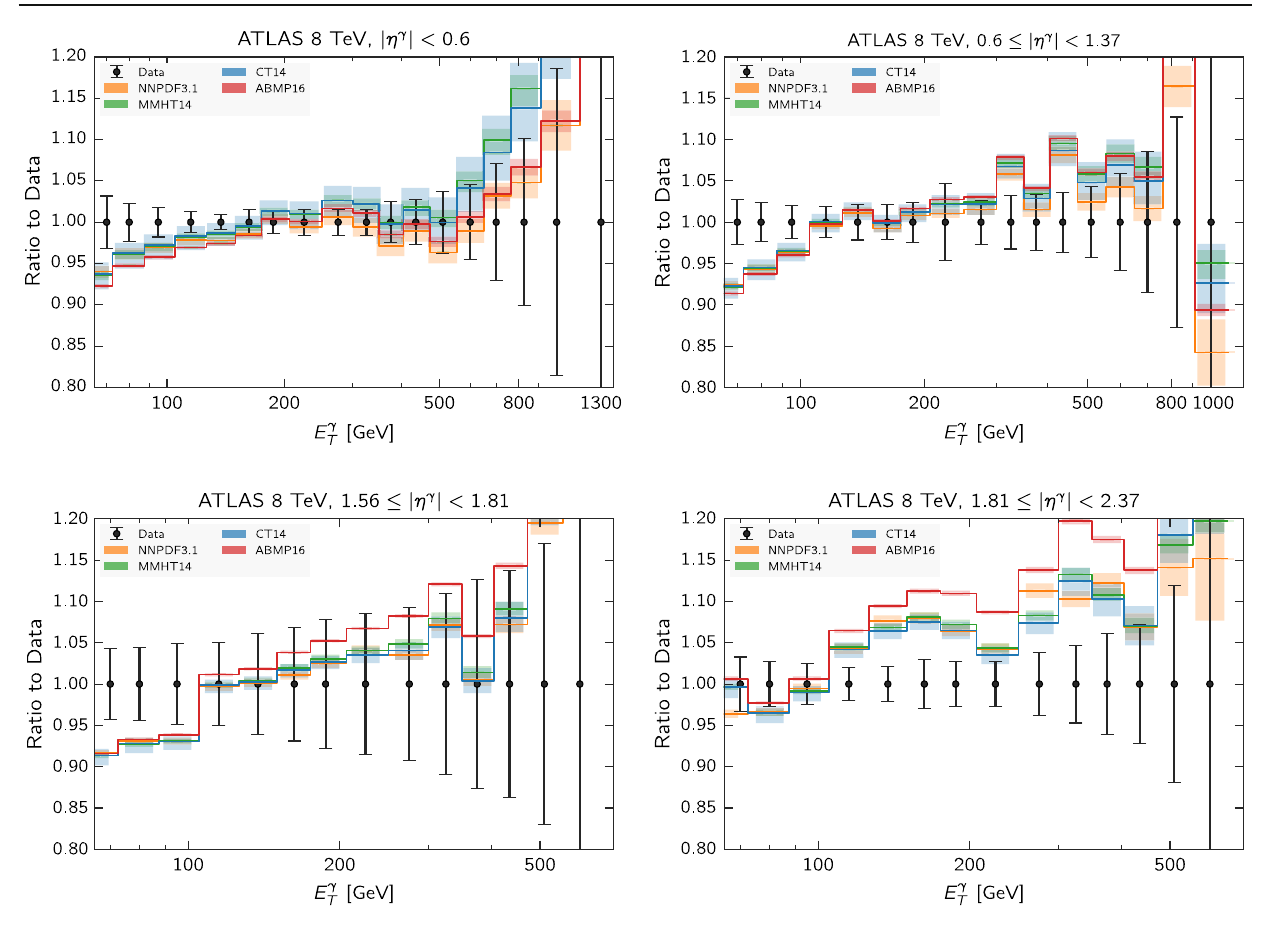
Fig. 5 Comparison between the theoretical predictions for direct pho- ton production data computed with different PDF sets and the ATLAS 8 TeV data, normalized to the central value of the former. The experimen-